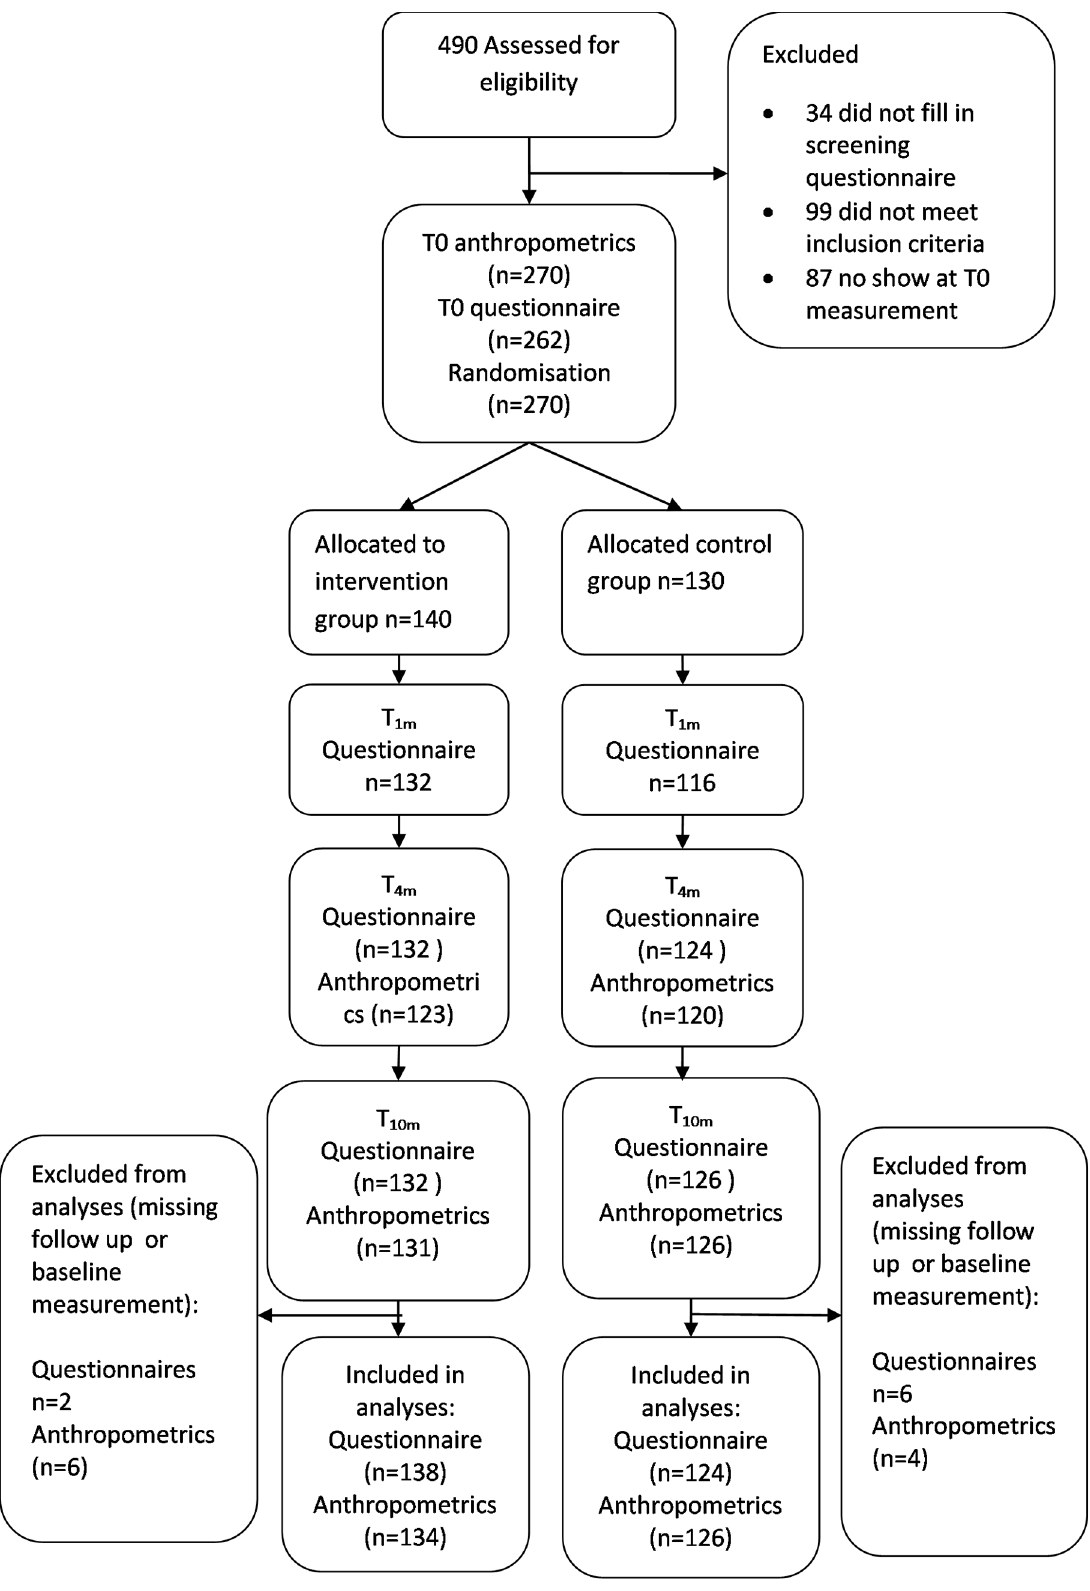
Fig 1. Participant flow